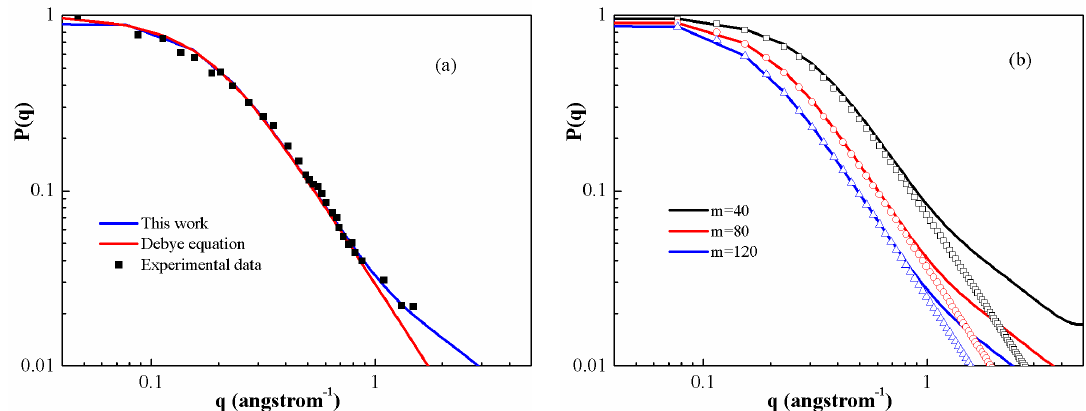
Figure 4. ( a ) Comparison between experimental data of the form factors and calculated ones for PS melt with the molecular weight 1 × 10 4 in θ solvent; ( b ) Form factor for different lengths of PS melt at 500 K. Solid lines correspond to DFT calculations in Equation (21). Symbols show the curve obtained from the Debye expression.